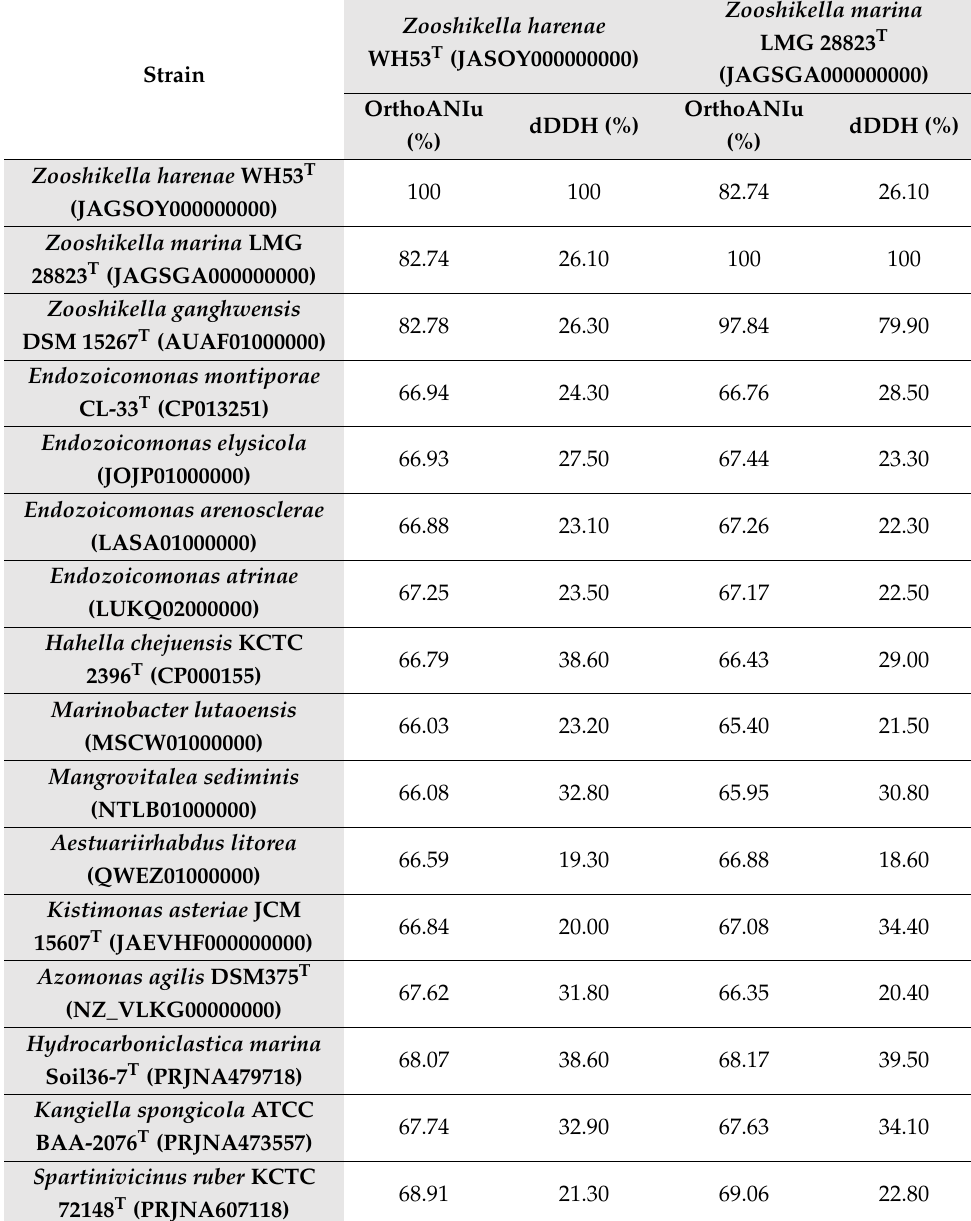
OrthoANIu values ≥ 95% and dDDH values >70% are shaded gray. Some phenotypic similarities exist between Z. marina LGM 28823 T and Z. ganghwensis DSM 15267 T , such as the same NaCl tolerance (5%) and some enzymatic activities. The genome was predicted to contain a total of 5214 genes, comprising 5180